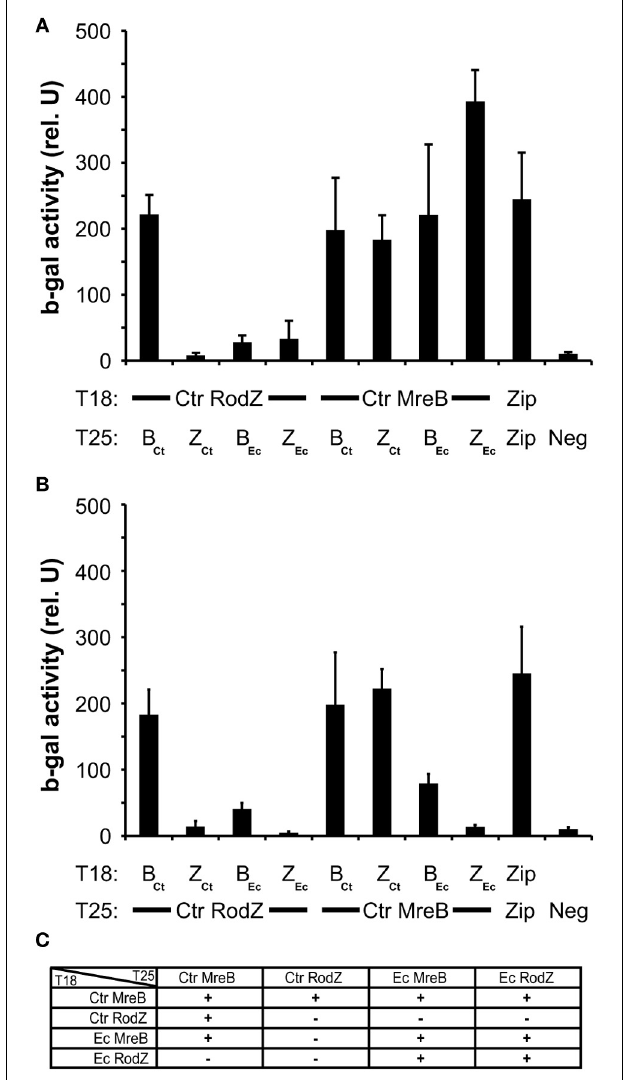
FIGURE 6 | Heterologous interactions between MreB and RodZ from Chlamydia and E. coli . The indicated constructs from the two species were tested in pair-wise fashion for their ability to interact in the BACTH assay. (A,B) Quantification of the ß-galactosidase activity as described in the legend of Figure 1 . Ctr, Chlamydia trachomatis ; Ec, Escherichia coli ; B, MreB; Z, RodZ (C) Summary of heterologous